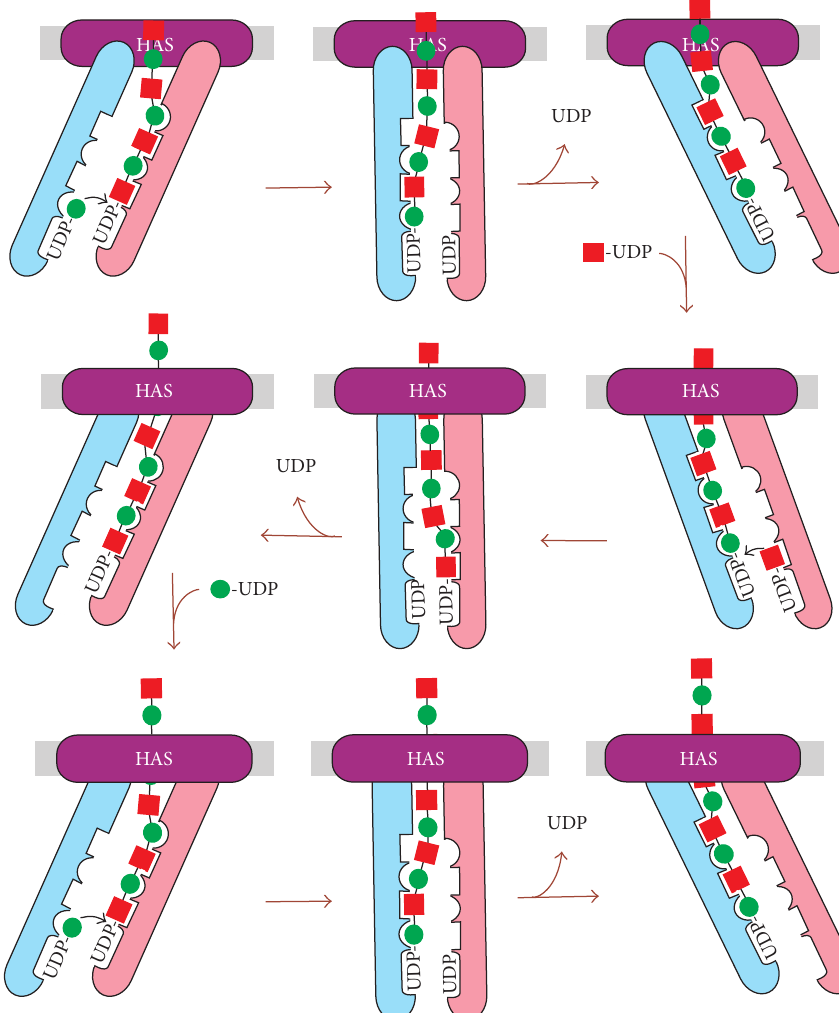
Figure 7: The Pendulum Model: Arm movement and HA transfer between arms drives HA chain translocation through the HAS ⋅ lipid complex to the cell exterior. The changing alignment of the HA-binding regions on the two arms in the two extreme positions (left and right) creates the ability of the enzyme to move the HA chain from one arm to the other (shown in each row). When the arms swing from one extreme position to the other, the HA chain is transferred from the first arm to the other arm as the HA-binding site alignments move out of (neutral position) and then back into register. A “time-lapse” of HAS action is illustrated in the nine panels as the enzyme adds three new sugars to an HA-UDP chain of seven sugars. The enzyme goes through three stages of arm movement (in each row) to add each new sugar. After assembly of each disaccharide, the enzyme arms are in the same starting position (e.g., the left panels in top and bottom rows). The sugars “crossing” the membrane are shown outside of the enzyme in the top row to help orient the reader, and then within the intraprotein pore in the middle and bottom rows. An animation of this process showing chain translocation through assembly of an HA 10-mer is at http://www.glycoforum.gr.jp/science/hyaluronan/HA06a/Pendulum Hypothesis Anima.files/slide0001.htm.